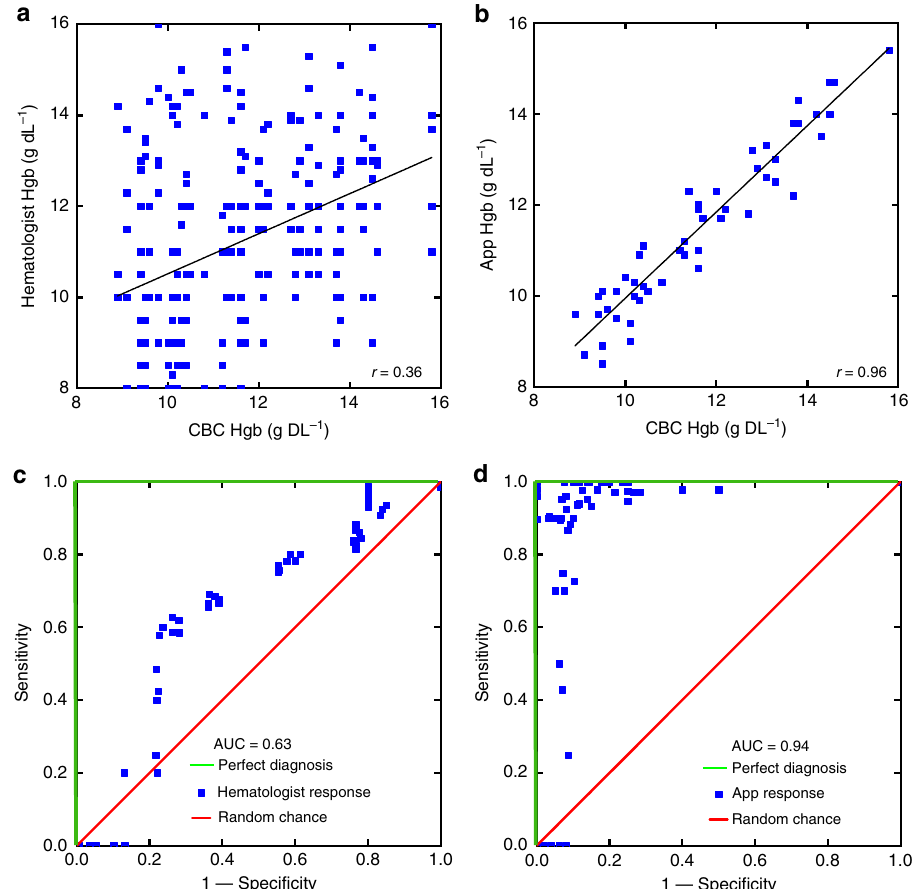
Fig. 6 App outperforms hematologists in physical exam-based hemaglobin measurement. Hematologists were able to estimate Hgb levels to within ±4.6 g dL − 1 ( a ) (95% limits of agreement) with an ROC of 0.63 ( c ). The app outperforms the hematologists in both respects with Hgb level accuracy measurement to within ±1.0 g dL − 1 ( b ) (95% limits of agreement) and an ROC of 0.94 ( d ). n = 50 subjects. Plots ( a , c ) represent the pooled results of 5 board-certi fi ed hematologists estimating blood hemoglobin levels based on images of patients fi